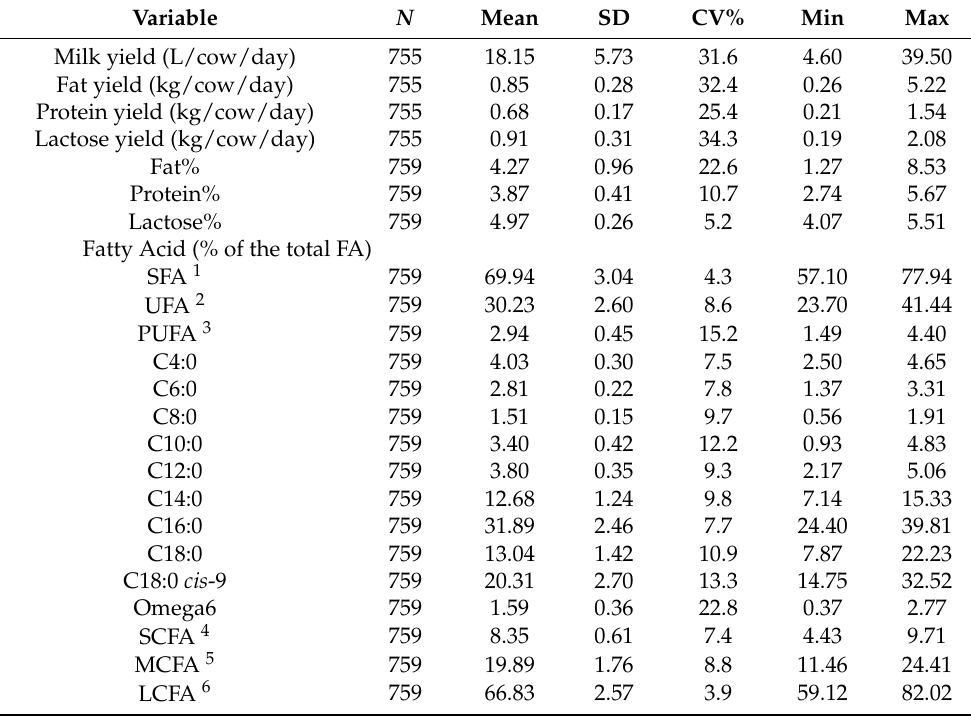
Table 2. Descriptive statistics of daily yields of milk, fat, protein and lactose, gross milk composition and fatty acid composition of cows milked during the 2020–2021 production season.